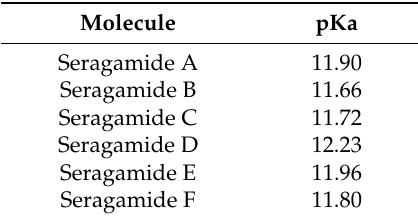
Table 3. pKas of Seragamides